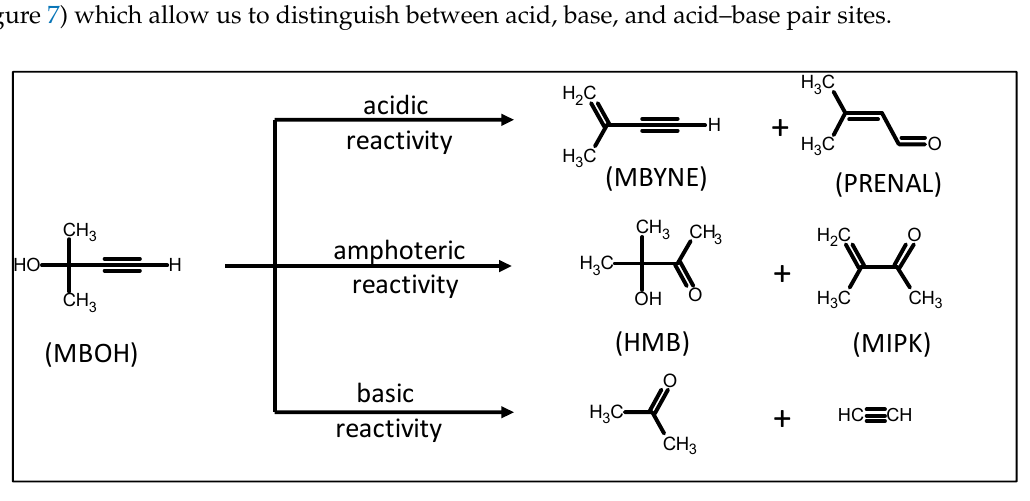
Figure 7. Overall reaction scheme as proposed by Lauron-Pernot et al. [25]. MBOH, 2-methyl-3-butyn-2-ol; MBYNE, 3-methyl-3-buten-1-yne; PRENAL, 3-methyl-2-buten-1-al; HMB, 3-hydroxy-3-methyl-2-butatone; MIPK, 3-methyl-3-buten-2-one.